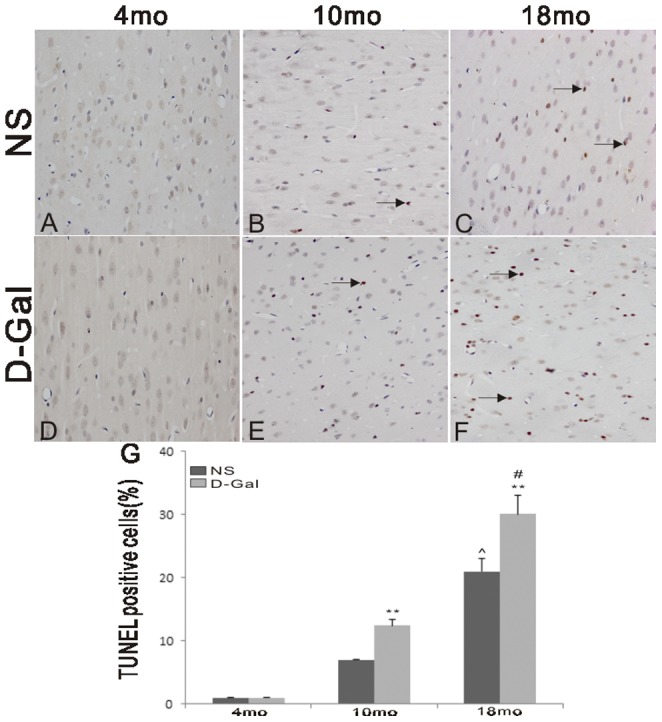
Cell apoptosis in the auditory cortex.Apoptotic cells were determined using TUNEL staining. No TUNEL-positive cellswere observed in the 4-month-old NS and D-Gal groups. The number of TUNEL-positive cells in the 10- and 18-month-old D-Gal group was significantly increased compared to the age-matched NS groups. **Significantly different from the NS groups (P<0.01). ∧Significantly different from the 4-month-old NS group (P<0.01). # Significantly different from the 4-month-old D-Gal group (P<0.01). Magnification: 400×. (n = 6 per subgroup).